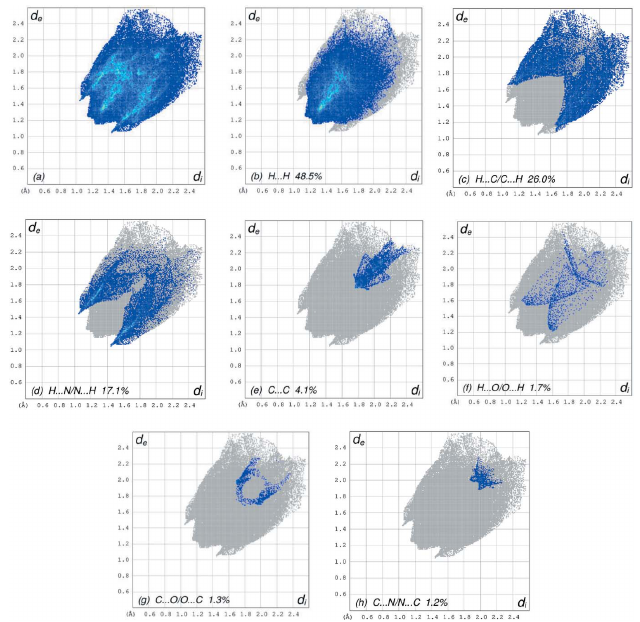
Figure 7 The full two-dimensional fingerprint plots for the title compound, showing ( a ) all interactions, and delineated into ( b ) H (cid:3)(cid:3)(cid:3) H, ( c ) H (cid:3)(cid:3)(cid:3) C/ C (cid:3)(cid:3)(cid:3) H, ( d ) H (cid:3)(cid:3)(cid:3) N/N (cid:3)(cid:3)(cid:3) H, ( e ) C (cid:3)(cid:3)(cid:3) C, ( f ) H (cid:3)(cid:3)(cid:3) O/O (cid:3)(cid:3)(cid:3) H, ( g ) C (cid:3)(cid:3)(cid:3) O/O (cid:3)(cid:3)(cid:3) C and ( h ) C (cid:3)(cid:3)(cid:3) N/N (cid:3)(cid:3)(cid:3) C interactions. The d i and d e values are the closest internal and external distances (in A˚ ) from given points on the Hirshfeld surface.